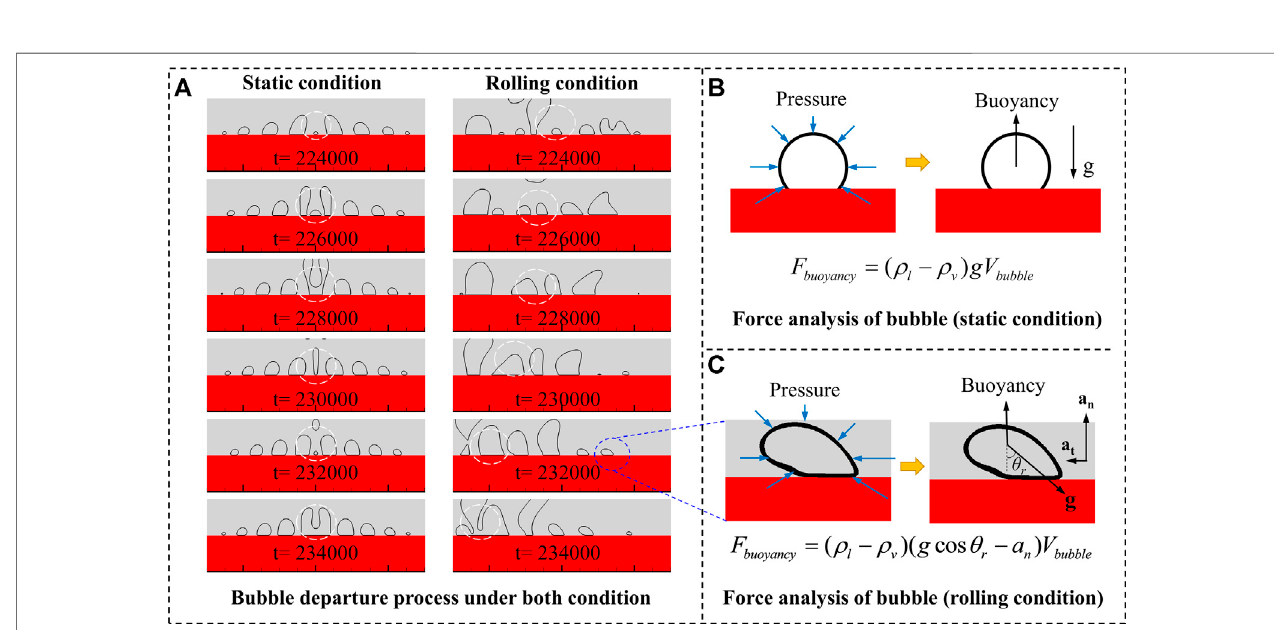
FIGURE 9 | Bubble departure process and the force analysis under static and rolling conditions.